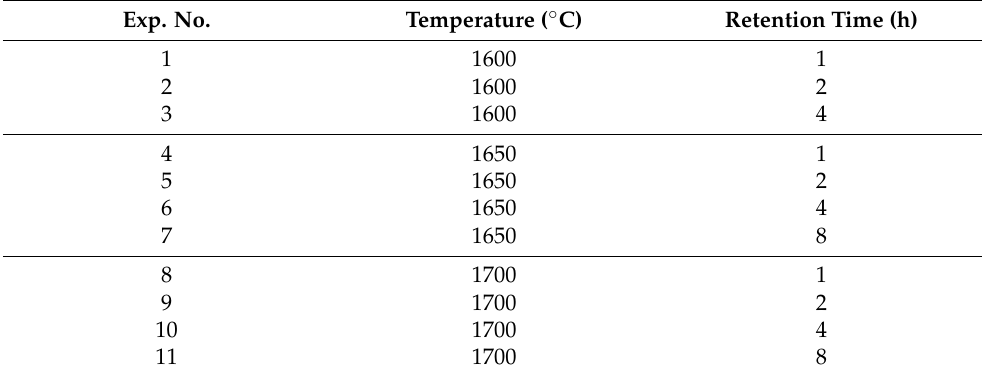
Table 1. Experimental